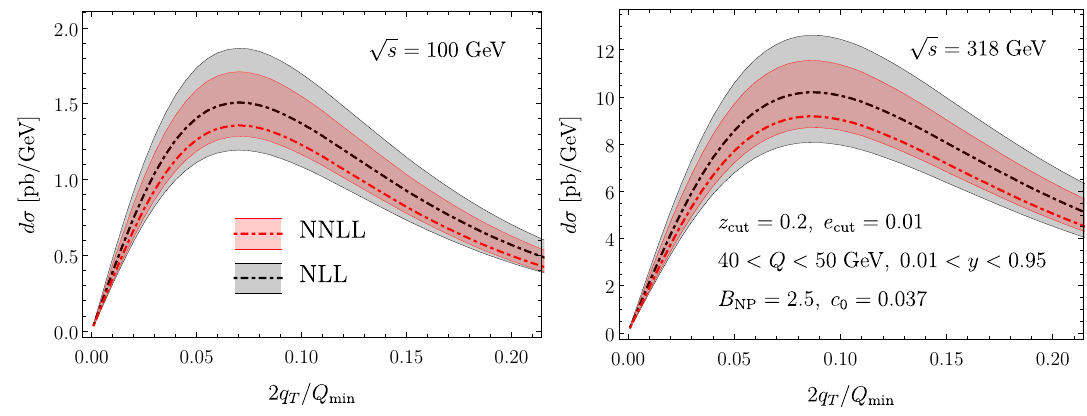
Figure 7 . The NLL and NNLL TMD spectra for groomed jets in DIS for EIC (left: √ 100 GeV) and HERA (right: √ s = 318 GeV) kinematics. The cross section are integrated in y = Q 2 / ( xs ) and Q = q 2 (see details in the main − (cid:31)